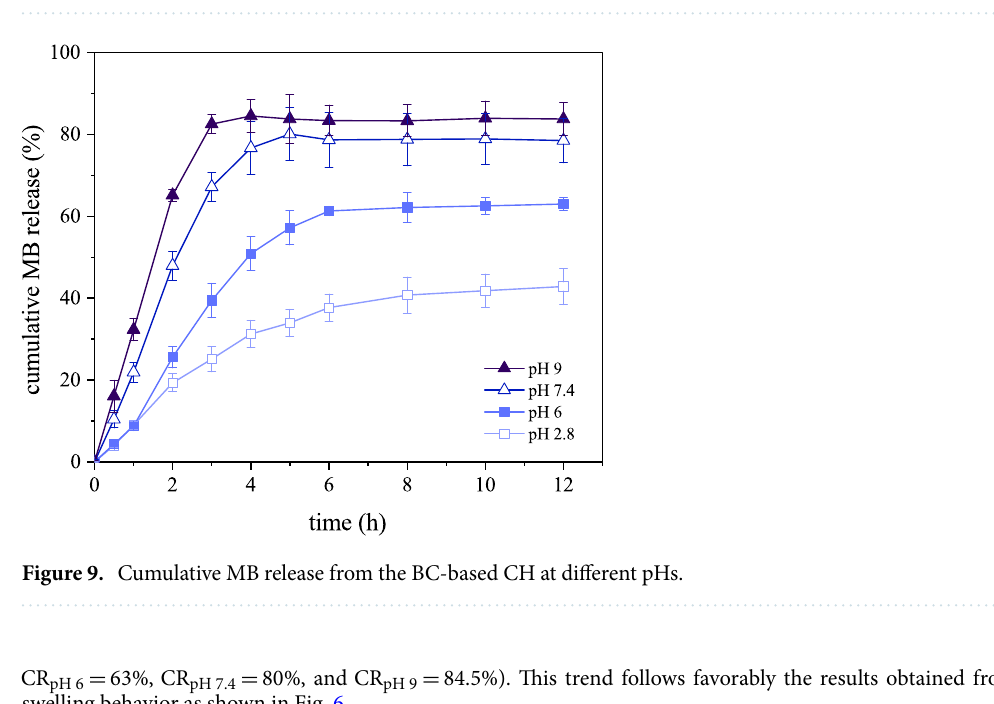
Figure 8. ( a ) The van’t Hoff thermodynamic plot and ( b ) Arrhenius equation used to plot lnk 2 vs 1/T for the adsorption of MB onto BC-based CH.